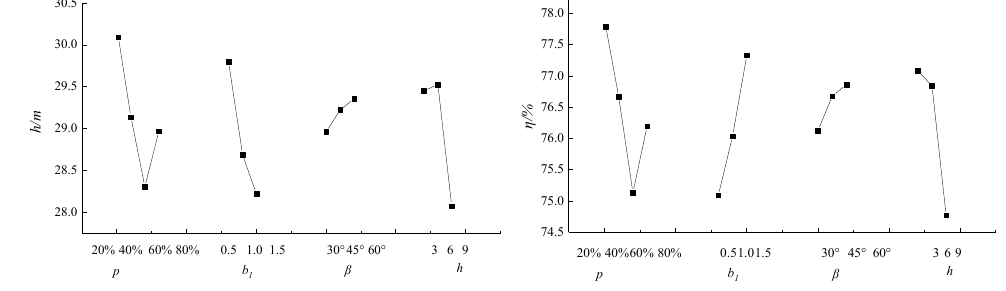
Figure 9. 1.4 Q head ( left ) and efficiency ( right )-factor relationship.